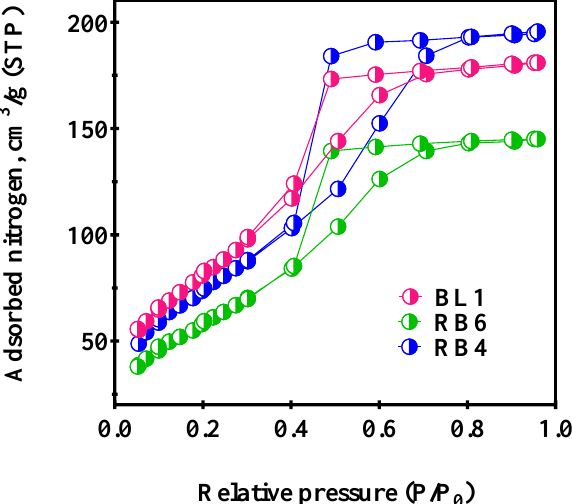
Figure 1. Nitrogen adsorption–desorption isotherms of BL1, RB4 and